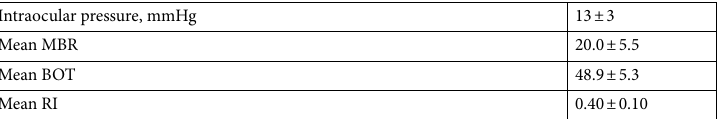
Table 1. Characteristic of the patients. Values are the mean ± 2SD, median and interquartile range, or n (%) of patients. A, peak mitral A wave velocity; ACEI, angiotensin converting enzyme inhibitor; ARB, angiotensin receptor blocker; baPWV, brachial-ankle pulse-wave velocity; BOT, Blowout time; BUN, blood urea nitrogen; CKD, chronic kidney disease; DM, diabetes mellitus; DLP, dyslipidemia; E peak mitral E wave velocity; e’ peak early diastolic myocardial velocity at septal position recorded by tissue Doppler imaging; E/e’ ratio, ratio of peak mitral E wave velocity to peak early diastolic myocardial velocity at the septal position by tissue Doppler imaging; eGFR, estimated glomerular filtration rate; HbA1c, hemoglobin A1c; HDL-Cho, high- density lipoprotein cholesterol; HTN, hypertension; IMT, intima media thickness; L-FABP, Liver-type Fatty Acid Binding Protein; LVEF, left ventricular ejection fraction; LVDd, left ventricular diastolic dimension; LVDs, left ventricular systolic dimension; LDL-Cho, low-density lipoprotein cholesterol; MBR, mean blur rate; NSTEMI, non ST elevated myocardial infarction; NT-ProBNP, N-terminal pro-brain natriuretic peptide; RI, resistivity index; STEMI, ST elevated myocardial infarction; TG, triglyceride; U-Alb, Urinary albumin